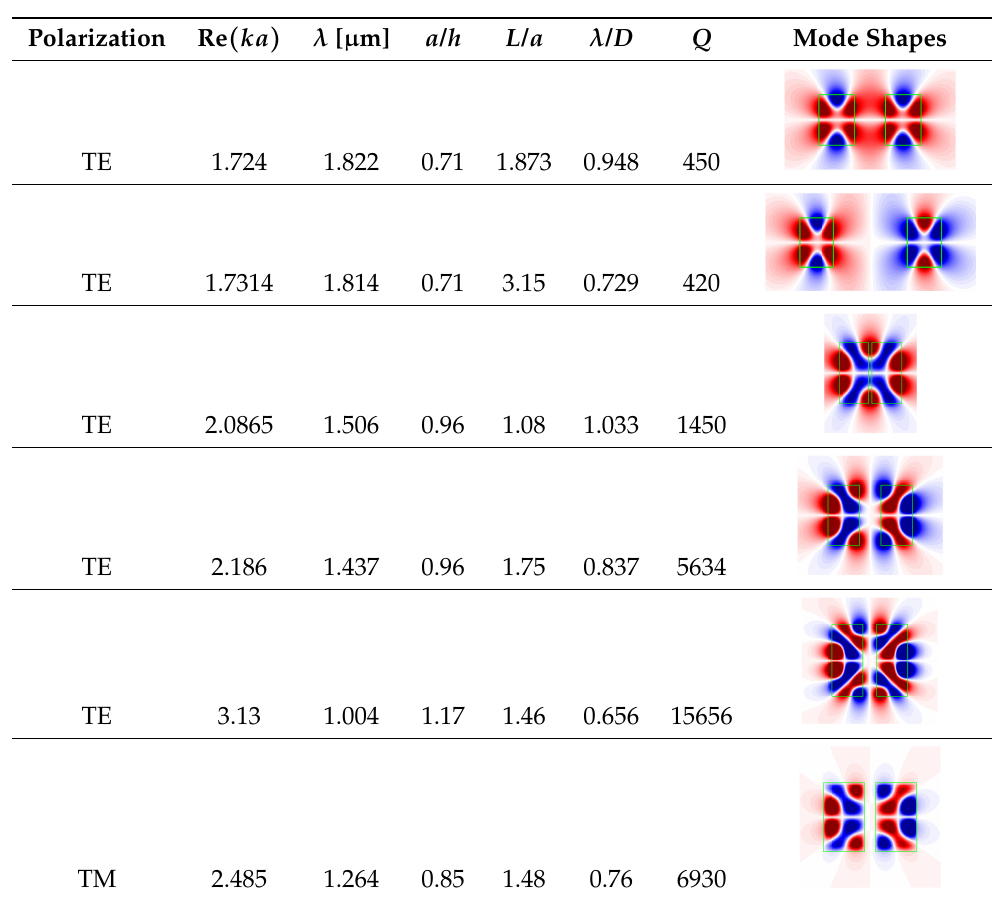
Table 1. Parameters of the high- Q resonant modes of two disks with radius a = 0.5 µ m and